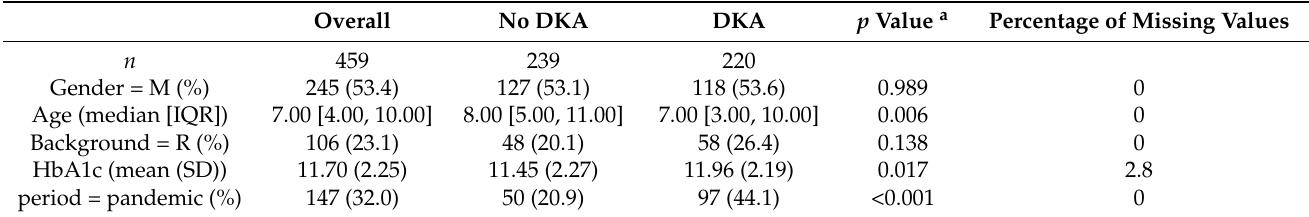
Table 3. Characteristics of the study sample, overall and according to DKA diagnosis. Overall